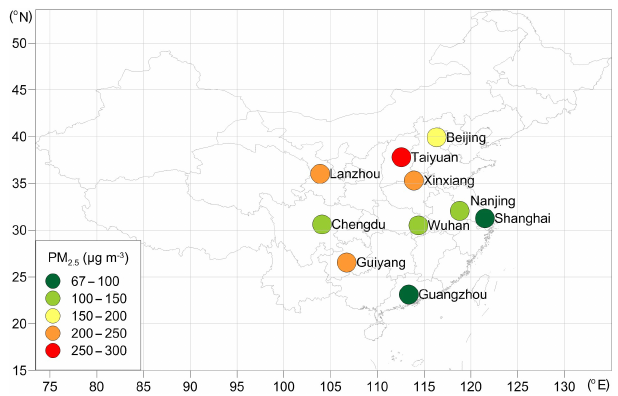
Figure 1. Geographic locations of the 10 Chinese sampling sites. The averages of monitored PM 2 . 5 concentrations (daily resolution, n = 31 for each site) during sampling campaign are shown in color